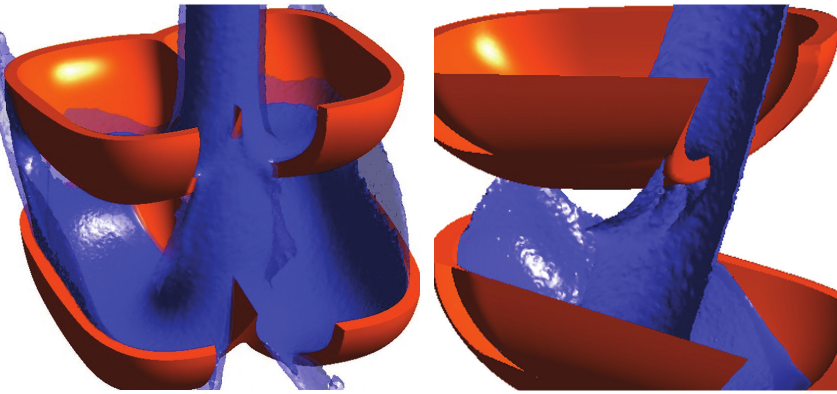
Figure 10: Diverged flow moving towards the first bucket.